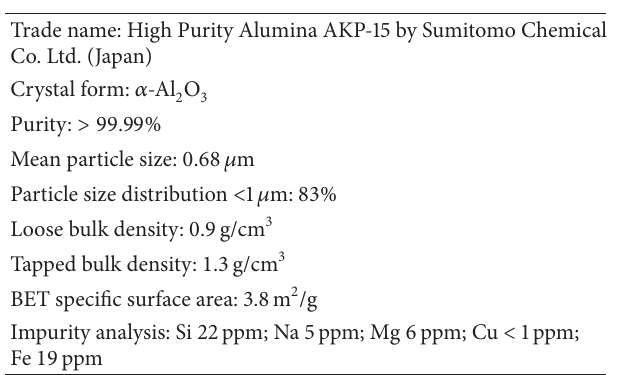
Table 1: Description of the alumina powder employed.